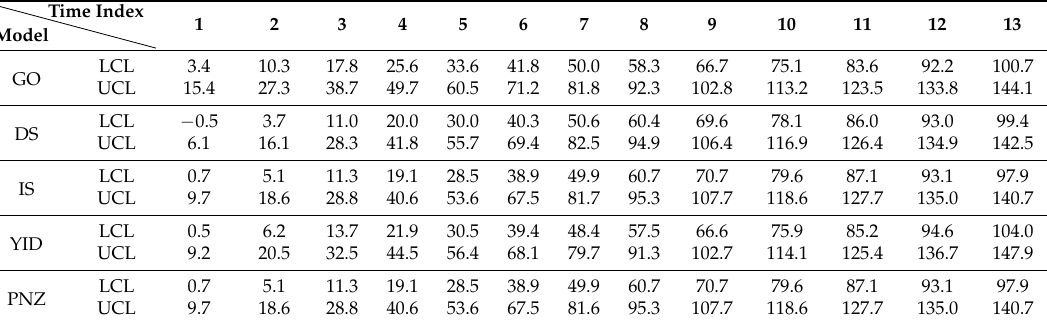
Figure A2. Confidence intervals of all 11 models Dataset #2: ( a ) GO Model; ( b ) Delayed S-shaped SRGM; ( c ) Inflection S-shaped SRGM; ( d ) Yamada Imperfect Debugging Model; ( e ) PNZ Model; ( f ) Pham-Zhang Model; ( g ) Dependent-Parameter Model1; ( h ) Dependent-Parameter Model2; ( i ) Testing Coverage Model; ( j ) Three-parameter Model. Table A1. Confidence interval of all 11 models from Dataset #1 ( α = 0.05). ModelTime